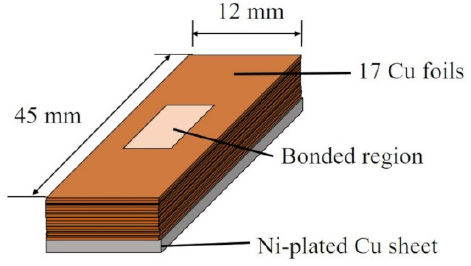
Figure 1. Specimen used in this study.